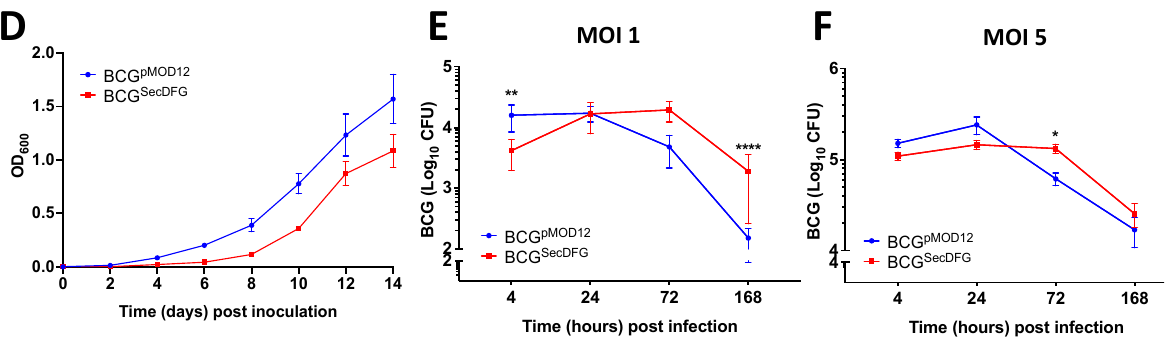
Figure 1. Characterization of recombinant BCG strains overexpressing M. tuberculosis SecDFG protein. ( A ). A schematic diagram of the recombinant prokaryotic expression plasmid, pMOD12-SecDFG. ( B ). Cell lysates (20 µ g) were prepared, separated on a 12% SDS-PAGE gel, and transferred to nitrocellulose membrane, and polyhistidine-tagged SecDF was detected using Ni-HRP conjugate for secondary detection of his-tagged proteins (Lane 1: BCG pMOD12 , Lane 2: BCG SecDFG clone 1, Lane 3: BCG SecDFG clone 2). ( C ). Culture supernatants and cell lysates (20 µ g) were examined by immunoblot using anti-Ag85 complex polyclonal antibody. ( D ). Bacterial growth in 7H9 medium (OD 600 ). Values represent mean ± SD of two independent cultures. E-F. RAW 264.7 murine macrophage cells were infected with rBCG strains a MOI of 1 ( E ) or 5 ( F ) and CFU was determined at indicated timepoints. Data are the means ± SEM ( n = 6) and are representative of two independent experiments. Statistical significance between groups was determined by ANOVA with Sidak’s multiple-comparisons